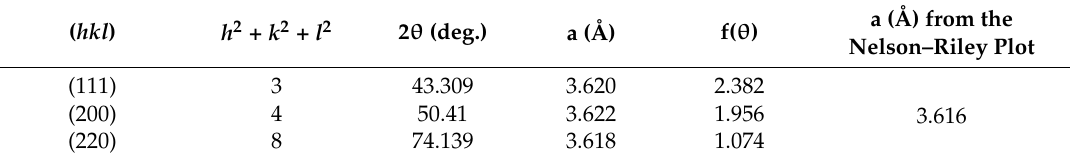
Table 5. Structural parameters of Cu in nanocomposite B with 20 vol % of TiC sintered at 900 ◦ C